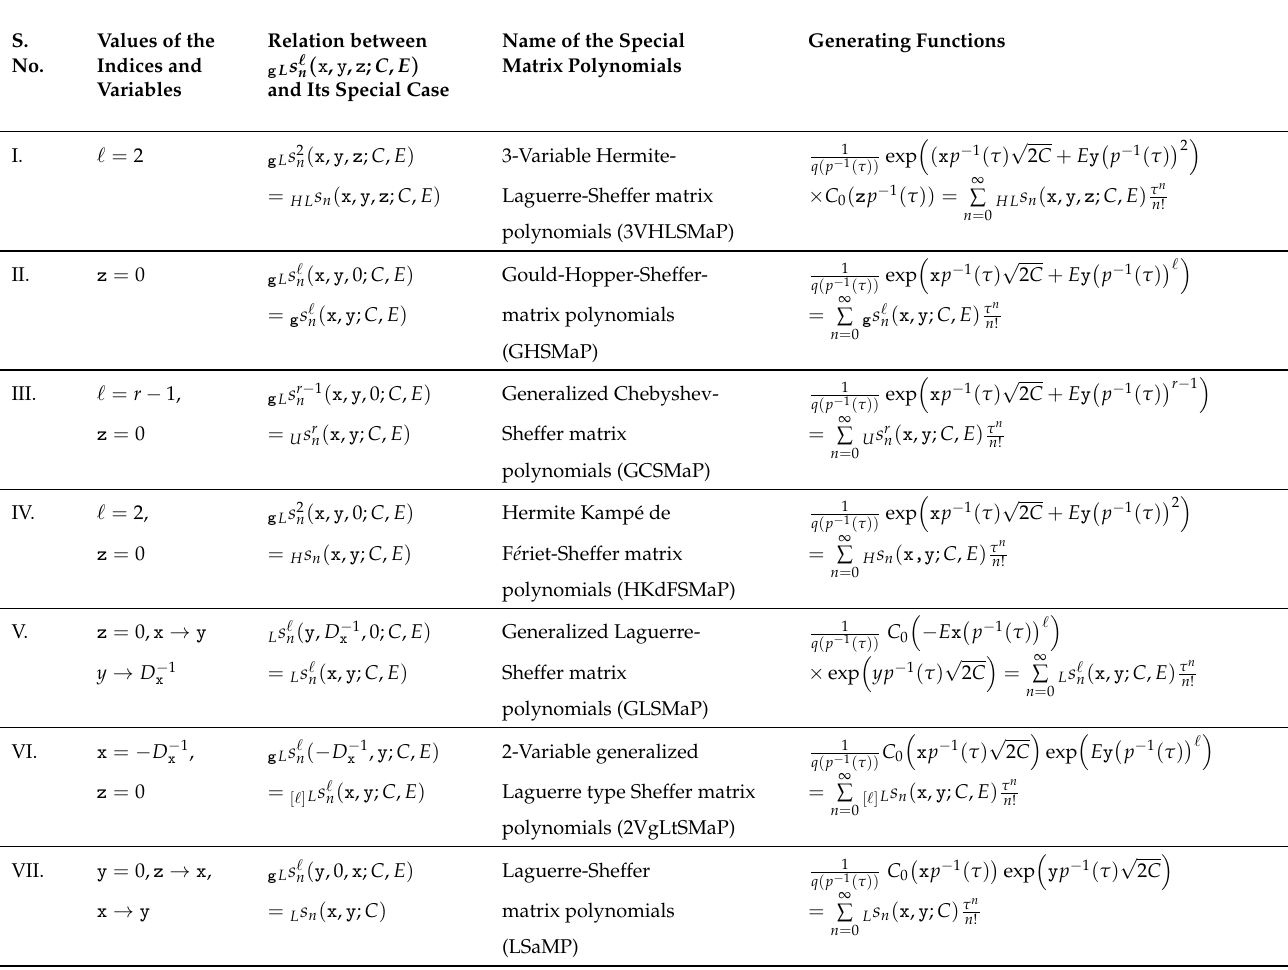
Table 1. Particular cases of the polynomials g L s (cid:96) n ( x , y , z ; C , E ) .